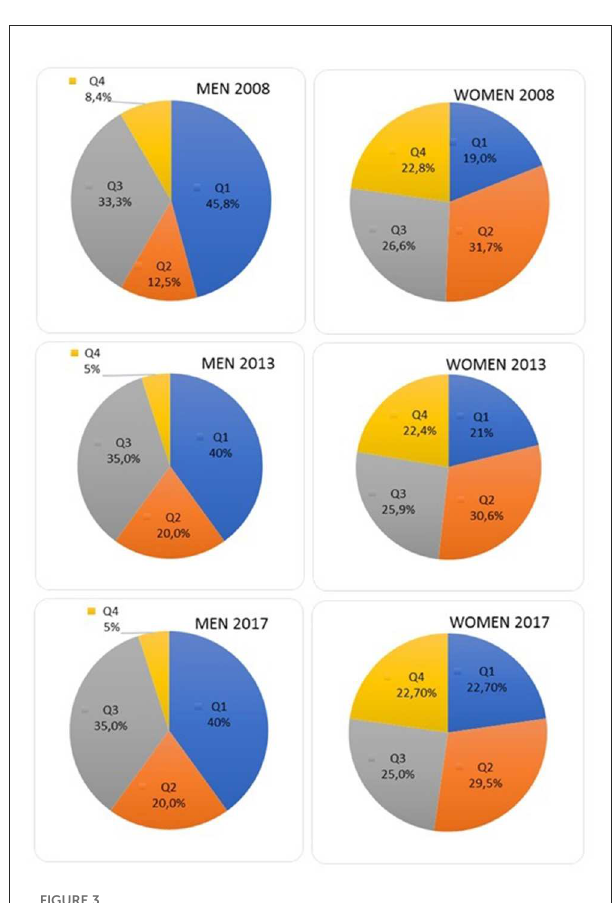
FIGURE3 Ratio of men/women by year and